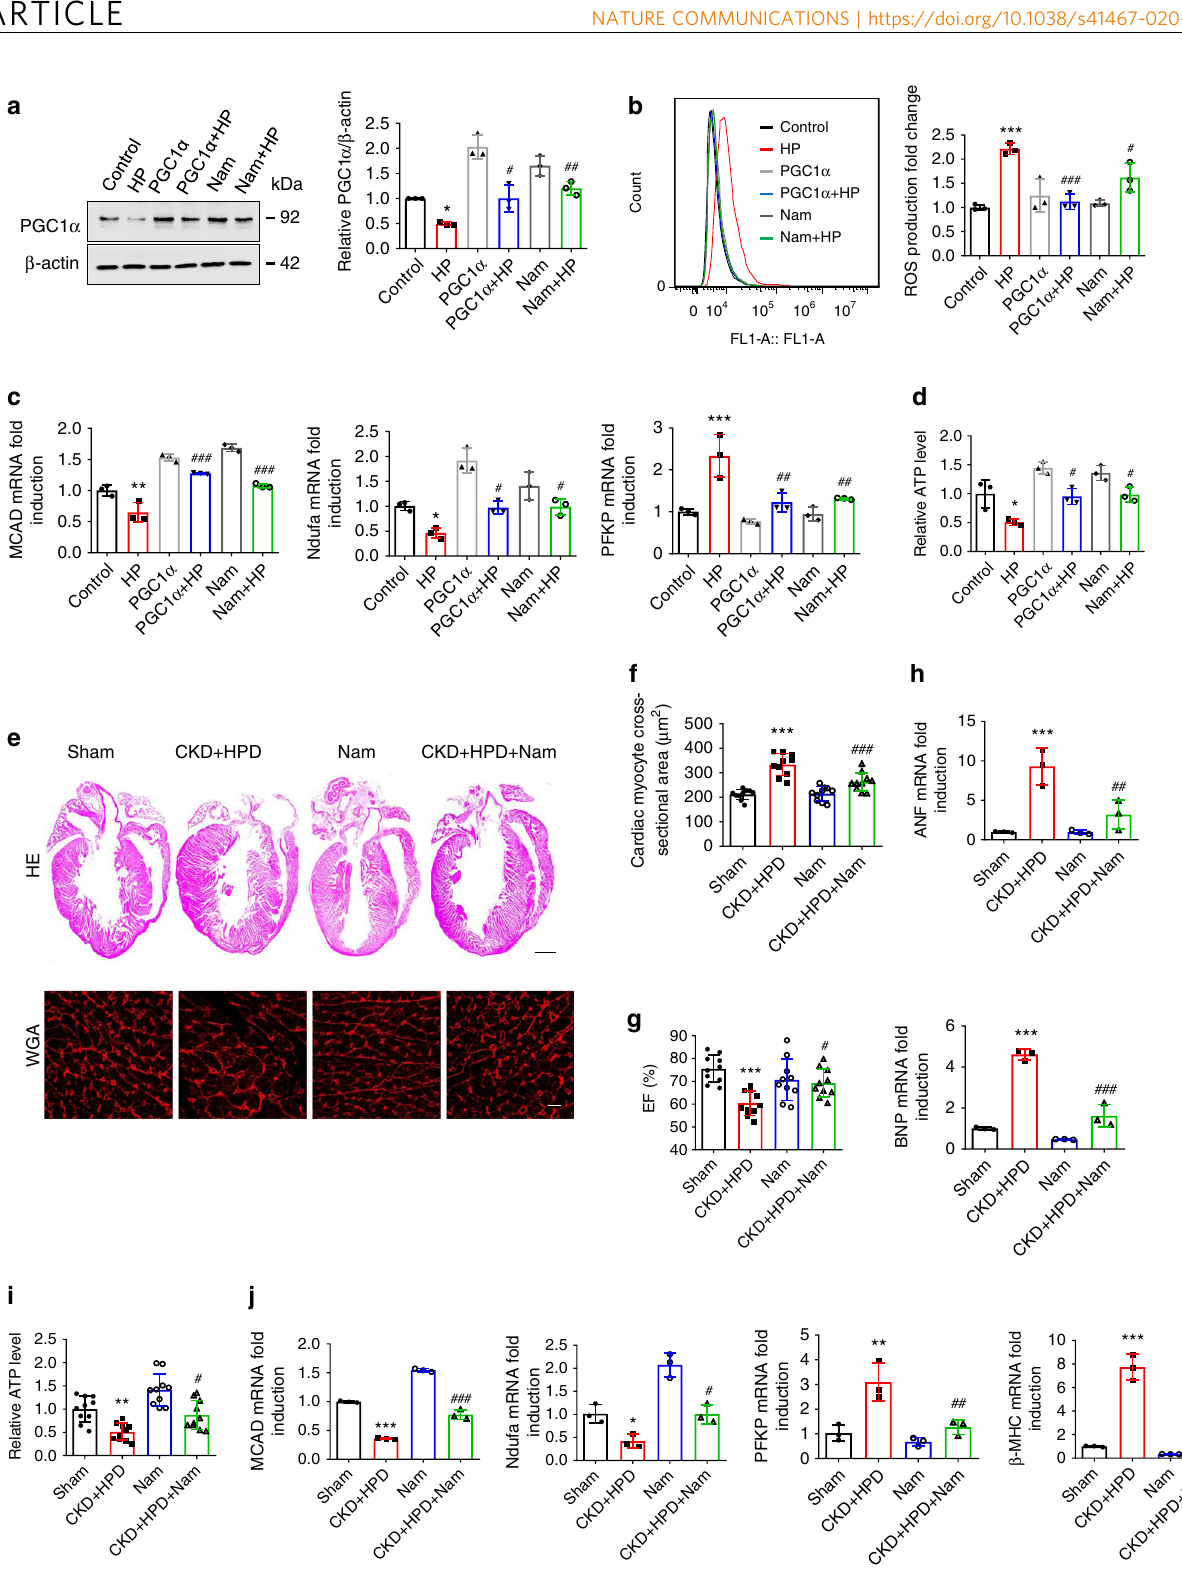
(Fig. 5h – l and Supplementary Fig. 5E, F). Moreover, PGC1 α was downregulated in IRF1 overexpression plasmids-transfected cells (Fig. 5m, n), and increased expressions of PGC1 α , PGC1 α target genes, and FAO- and OXPHO-related genes were detected in IRF1 − / − mice (Supplementary Fig. 5G – K). All these data support the hypothesis that IRF1 may mediate the effect of HP on PGC1 α